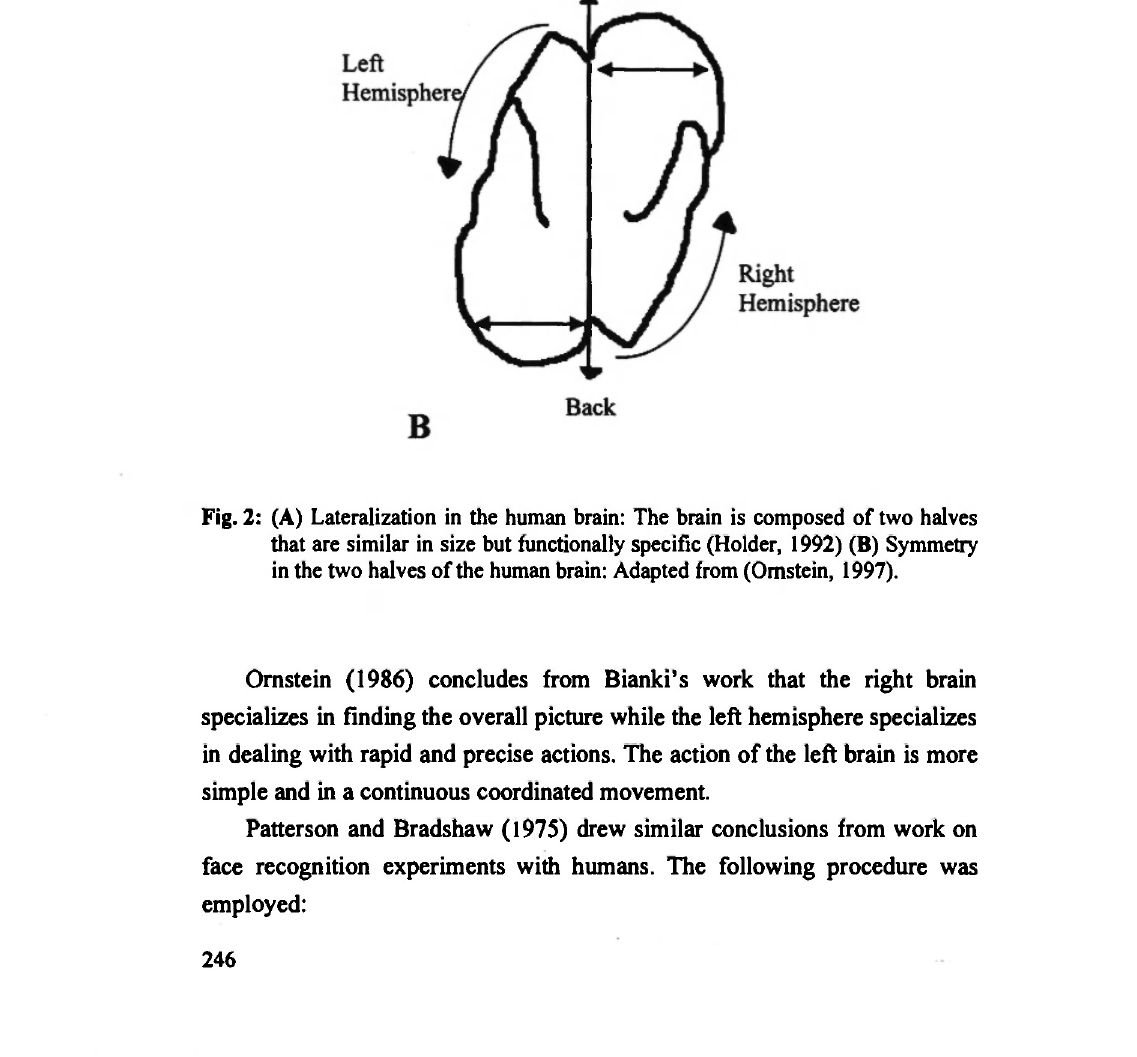
Fig. 2: (A) Lateralization in the human brain: The brain is composed of two halves that are similar in size but functionally specific (Holder, 1992) (B) Symmetry in the two halves of the human brain: Adapted from (Ornstein, 1997).